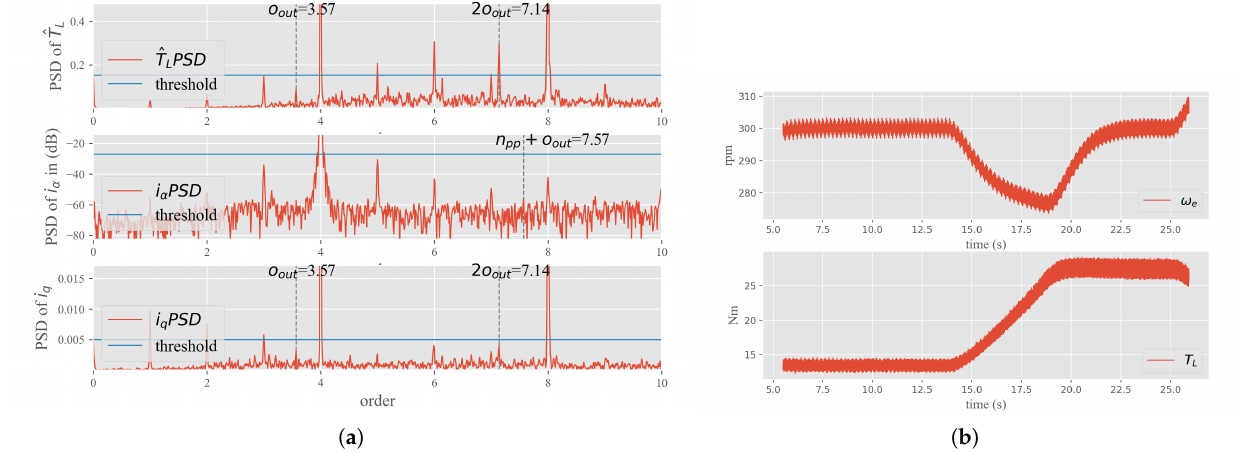
Figure 11. Torque varying experiments (Case2) of the bearing fault motor ( a ) power spectrum density and ( b ) graphical transients of speed and